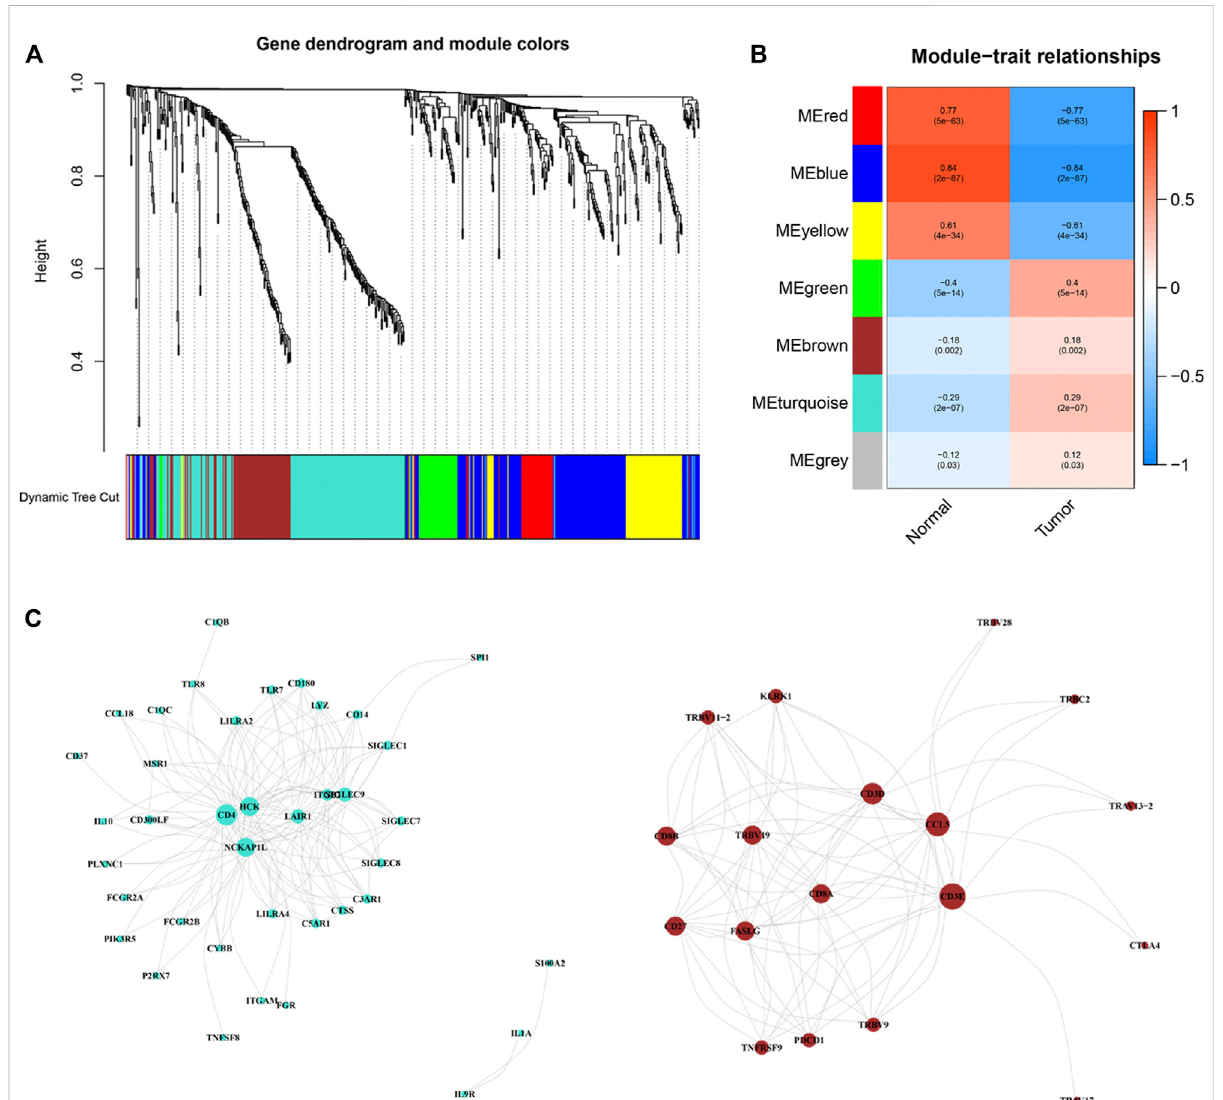
FIGURE 3 Weighted correlation network analysis and co-expression network analysis. (A) Dendrogram showing all differentially expressed genes clustered based on different metrics. (B) Heat-map of the correlation between gene modules and the clinical phenotypes of PRCC. (C) Visualization of turquoise and brown modules gene networks. PPRC, papillary renal cell